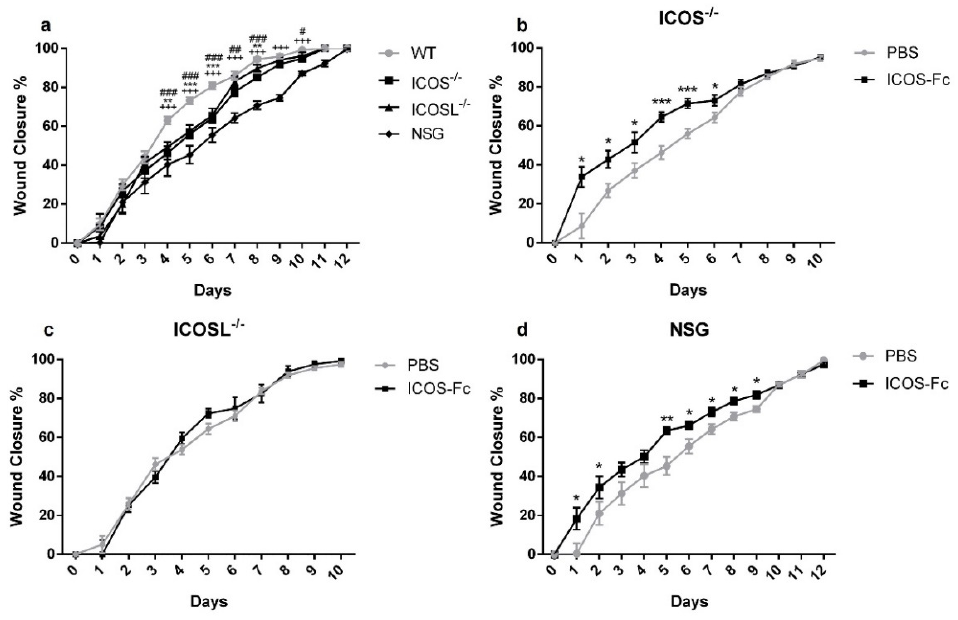
Figure 7. Effect of treatment with ICOS-Fc on wound healing in various KO mice. Wound healing % was calculated as described in the legend to Figure 2. ( a ) Comparison of wound healing in wild-type mice (n = 21), ICOS − / − (n = 16), ICOSL − / − (n = 18), and NSG (n = 15) mice. ( b – d ) Effect of treatment with ICOS-Fc on wound healing in ICOS − / − (PBS: n = 16; ICOS-Fc: n = 11), ICOSL − / − (PBS: n = 9; ICOS-Fc: n = 9), and NSG (PBS: n = 15; ICOS-Fc: n = 16) mice. * p < 0.05; ** p < 0.005; *** p < 0.001; # p < 0.05; ## p < 0.005; ### p < 0.001; +++ p < 0.001; calculated by Mann–Whitney test.